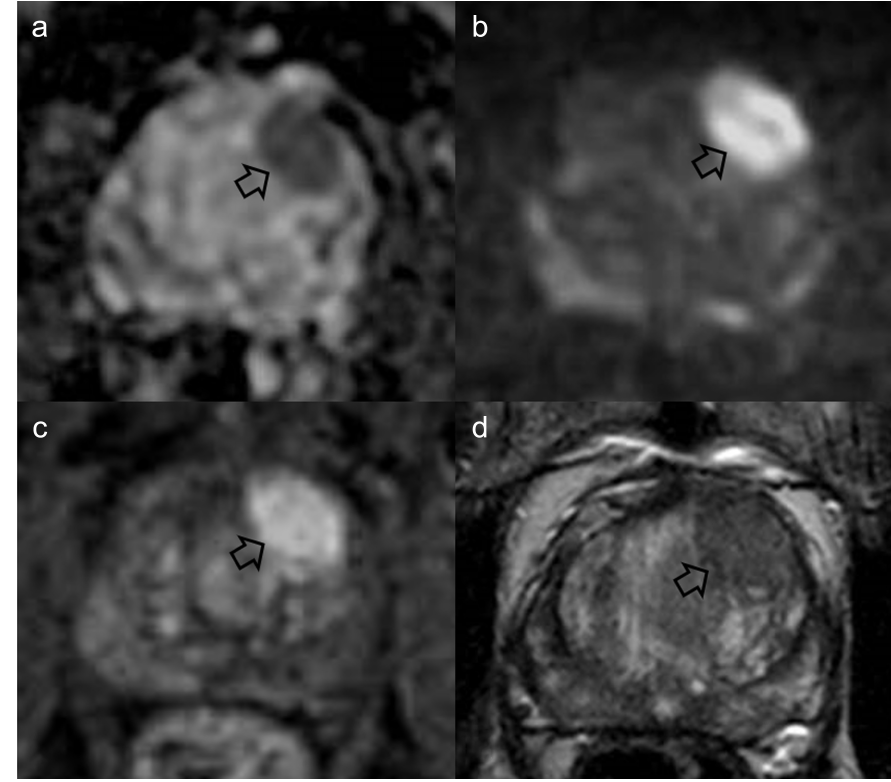
Figure 1. a-d. Multiparametric MRI in a 63-year-old man with persistently elevated serum PSA level (8.4 ng/mL). PIRADS score 3b lesion in the left anterior transition zone to the middle of the prostate gland. Target biopsy was performed. The lesion is moderately hypo-intense on the ADC map (arrow in a), hyper-intense on DWI at high b-values (arrow in b) with early intense enhancement on DCE (arrow in c), and moderately hypointense on the T2-weighted image (arrow in d). GS 7 (3+4) prostate adenocarcinoma in 4 out of 4 target cores was found at histology. No cancer was detected in the peripheral zone at the random biopsy (8 cores). The patient underwent radical prostatectomy and a final histopathological examination confirmed the biopsy findings (prostate adenocarcinoma GS 3+4 pT2c, R0, N0,